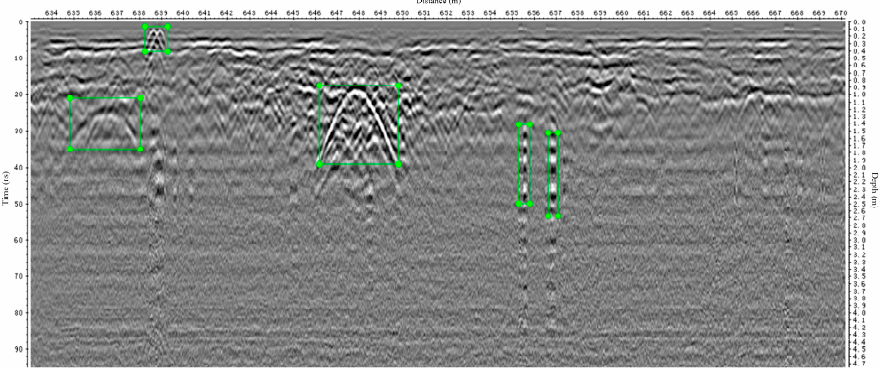
Figure 1. Parabolic target feature marker.